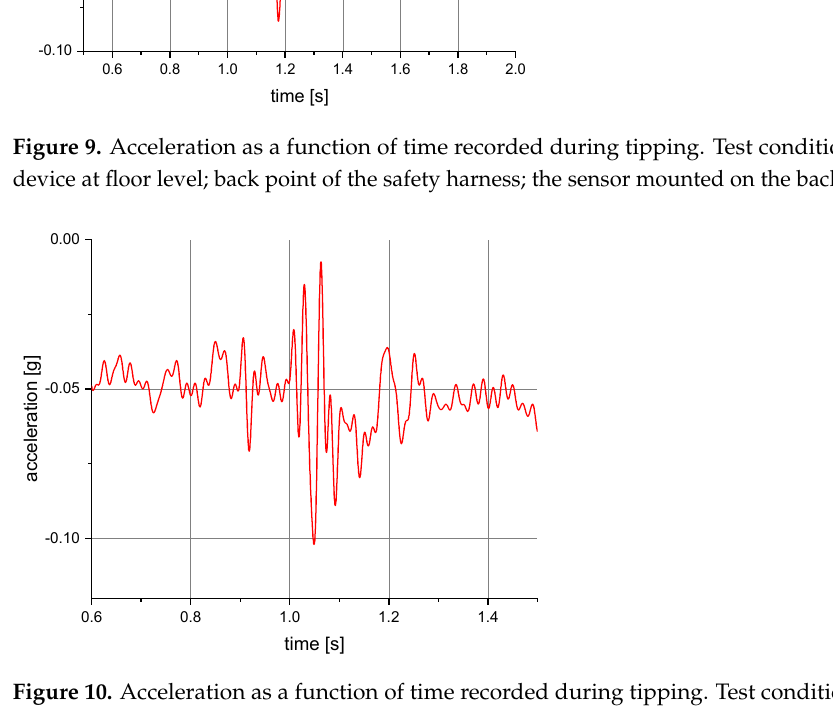
time [s] Figure 8. Acceleration as a function of time recorded during tipping. Test conditions: self-locking